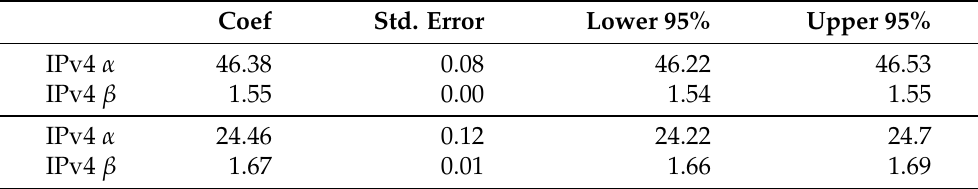
Figure 10. Estimation of address location lifetime. The approximated parametric model is also shown. Table 5. Fitted Log logistic model parameters. α also equals to median